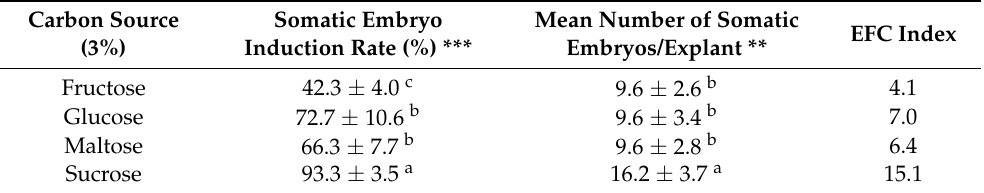
Figure 2. Somatic embryogenesis of P. ginseng in the presence of four carbon sources after 60 days. ( A ) Fructose, ( B ) glucose, ( C ) maltose, and ( D ) sucrose. Scale bars, upper: 1 cm; lower: 1 mm. Table 1. Effect of carbon source in induction medium on somatic embryogenesis of P. ginseng